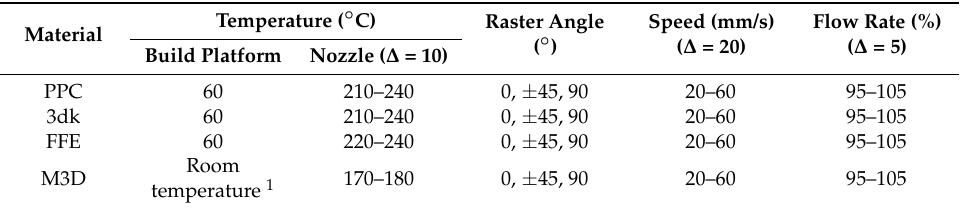
Table 3. Design of experiments for analyzing factors of influence on electrical resistivity with utilized process parameters for the manufacturing of the test